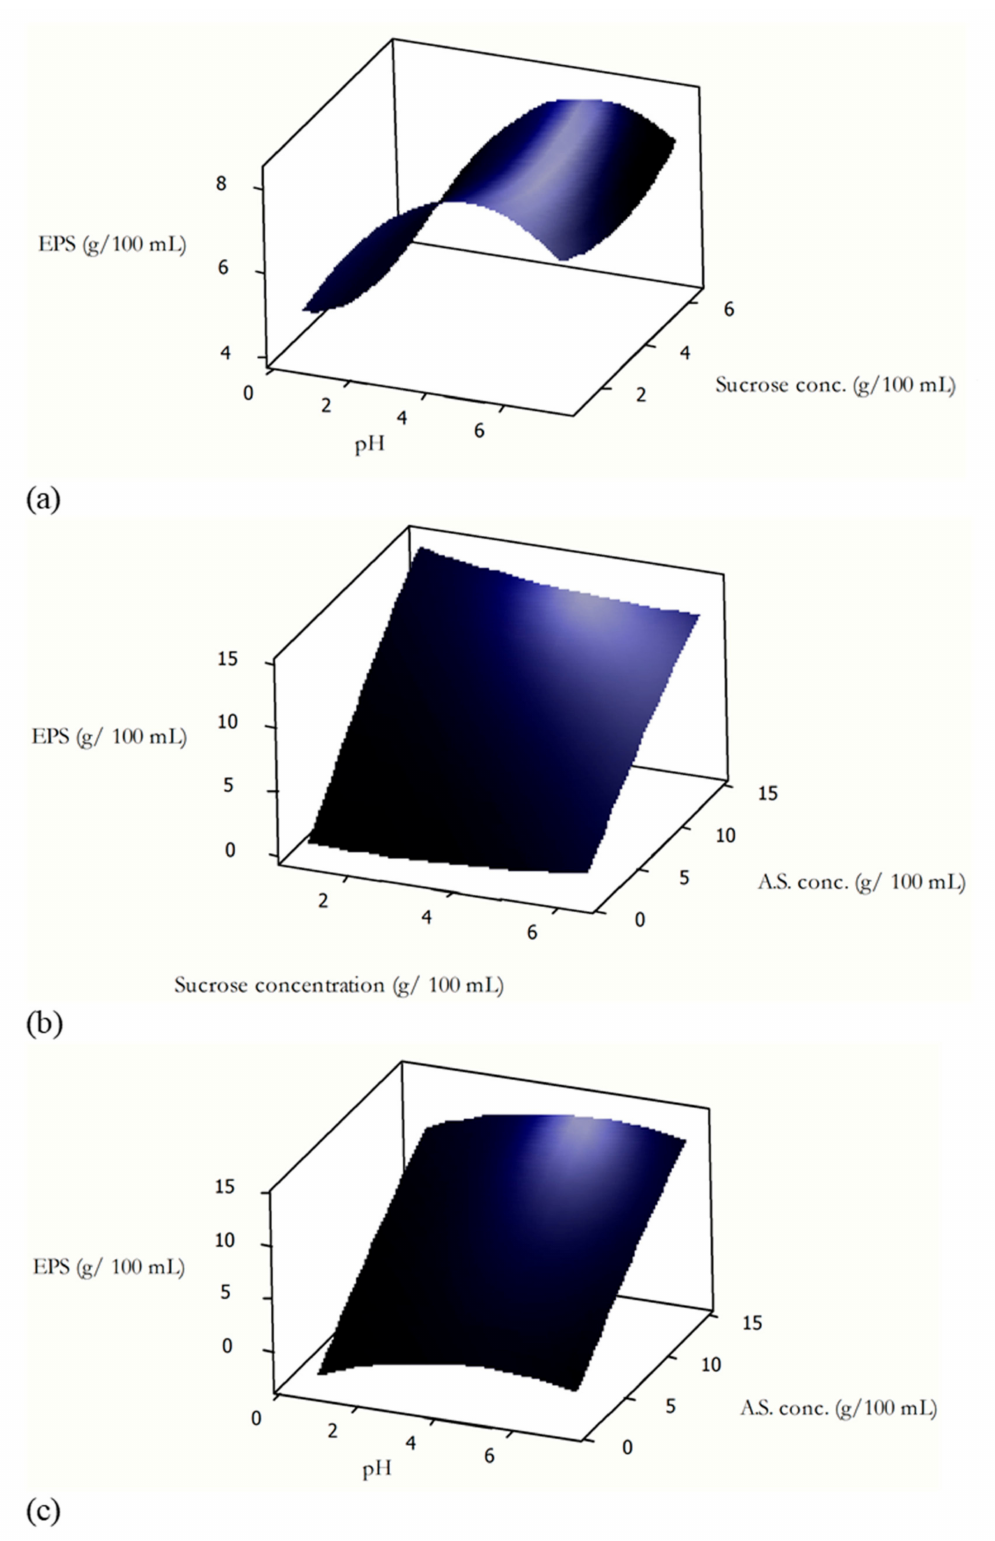
Figure 2. Surface plot highlighting the effect of process variables on the crude EPS yield (EPS, g/100 mL). ( a ) denotes the 3D surface plot showing variations in crude EPS yield as pH and sucrose concentration changes at constant ammonium sulfate concentration of 8 g/ 100 mL. ( b ) denotes the 3D surface plot showing variations in crude EPS yield as sucrose concentration and ammonium sulfate concentration changes at a constant pH of 4. ( c ) denotes the 3D surface plot showing variations in crude EPS yield as pH and ammonium sulfate concentration changes at a constant sucrose concentration of 3 g/ 100